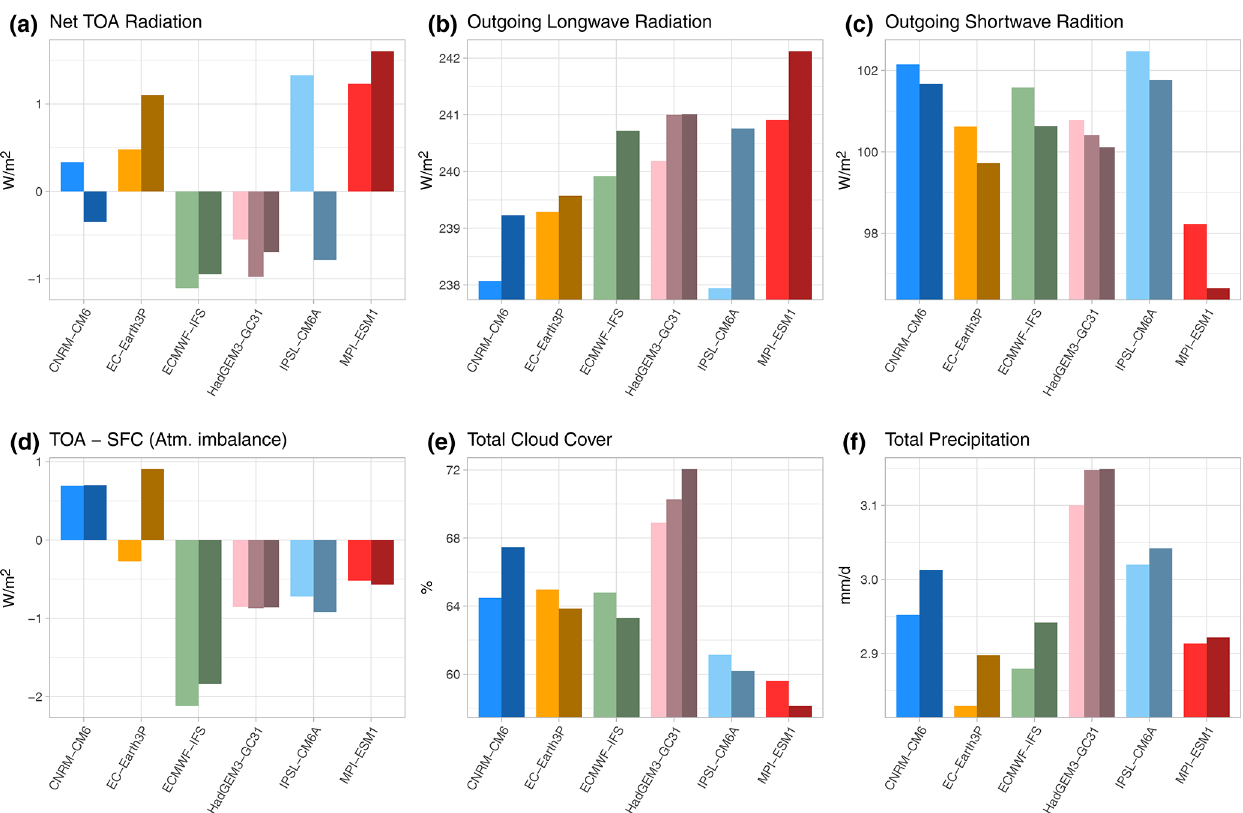
Figure 8. Global yearly averaged mean (a) net TOA radiation, (b) outgoing long-wave radiation, (c) outgoing short-wave radiation, (d) at- mosphere imbalance, (e) total cloud cover and (f) total precipitation in HighResMIP atmosphere-only simulations. Darker colours indicate higher horizontal